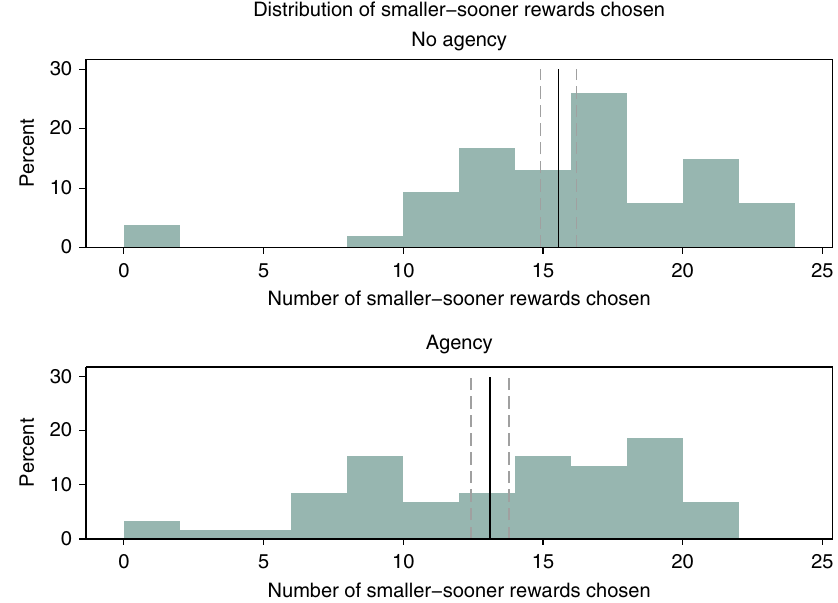
Fig. 5 Study 2 results: distribution of smaller-sooner rewards chosen, by treatment group. N = 113 participants. Black solid line denotes mean; gray dashed lines denote mean values ± 1 SE. Table 2 Study 2